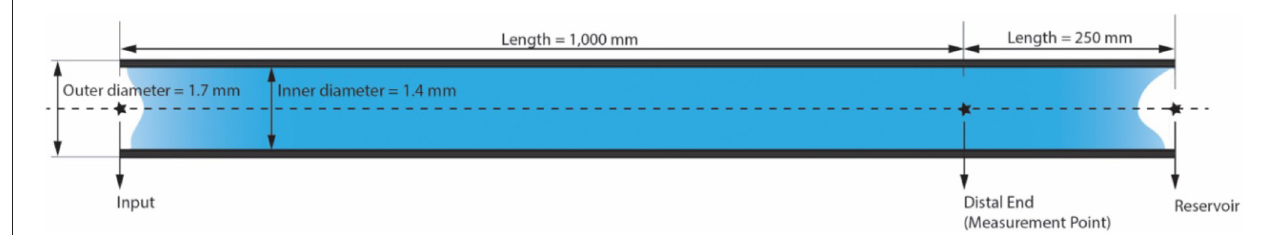
FIGURE 2 | Sketch of COMSOL model of the catheter shaft filled with a fluid.